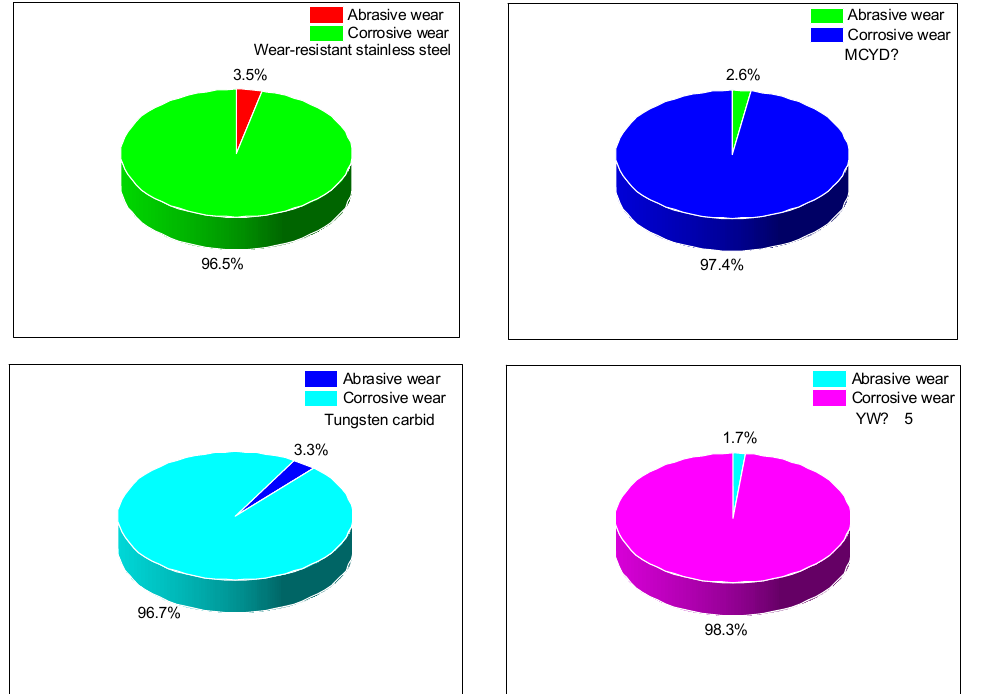
Figure 15. Proportion of abrasive wear and corrosion wear. Figure 15 can reflect the corrosion resistance of the four alloys to a certain extent. Taking the metal of the end face as the only variable, there are different amounts of small